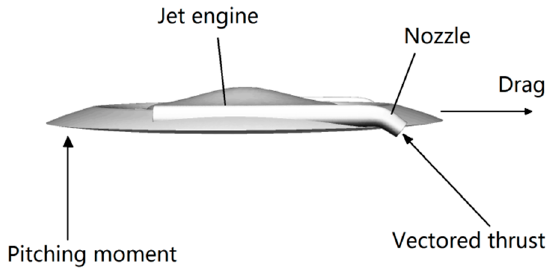
Figure 12. Thrust vectoring for attitude control and to eliminate the pitching torque.